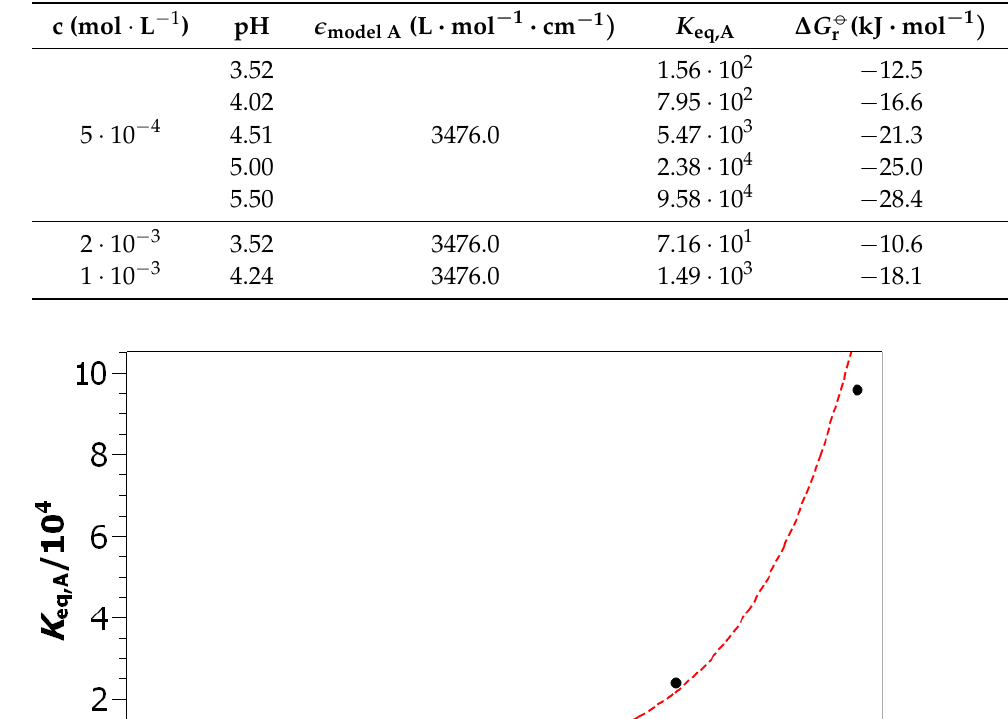
Table 2. Parameters obtained by fitting Model A to the experimental points of the Job plot.